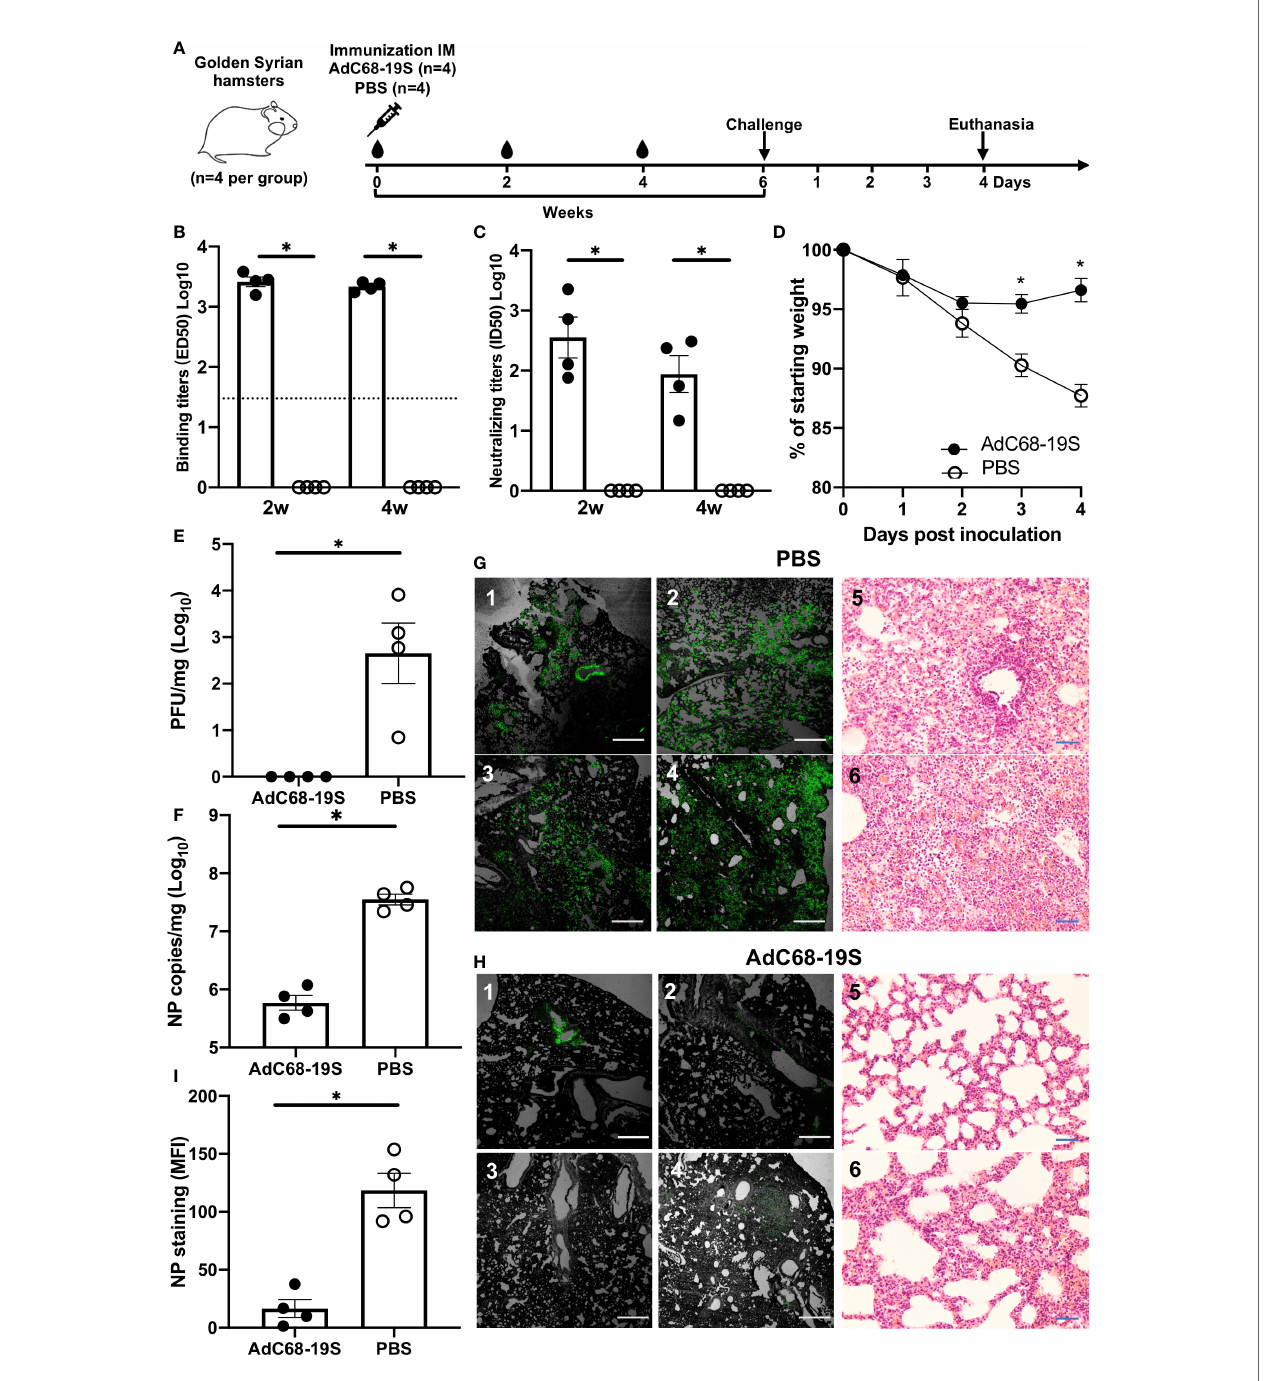
FIGURE 3 | AdC68-19S elicits a protective immune response against SARS-CoV-2 infection in golden Syrian hamsters. (A) Timeline for vaccination, challenge with live SARS-CoV-2 and virological, immunological, and pathological characterization. The hamsters were immunized with AdC68-19S (n = 4) or saline as control (n = 4) via the IM route. (B) The binding ability of total IgG and neutralizing ability of immune serum to SARS-CoV-2 RBD on week 2 and week 4 after immunization. (C) The neutralizing ability of the serum samples against SARS-CoV-2 pseudovirus. (D) Weight loss in SARS-CoV-2 challenged hamsters. Lung viral load measured by (E) plaque forming unit (PFU) and (F) qPCR. Immunostaining of NP antigen in lung tissue sections detected by a fl uorescent monoclonal antibody against SARS-CoV-2 nucleocapsid protein and hematoxylin and eosin staining (20×) (G , H) . The scale bar was 500 m m for immunostaining and 100 m m for HE staining. (I) The actual values of mean fl orescence intensity (MFI) measured. Data corresponding to animals in the AdC68-19S group are shown in solid circle, and those in the PBS group in hollow circle. Dotted lines re fl ect assay limit of detection. All data are presented as the means ± SEM. Analysis of unpaired Mann – Whitney test was used (*P <